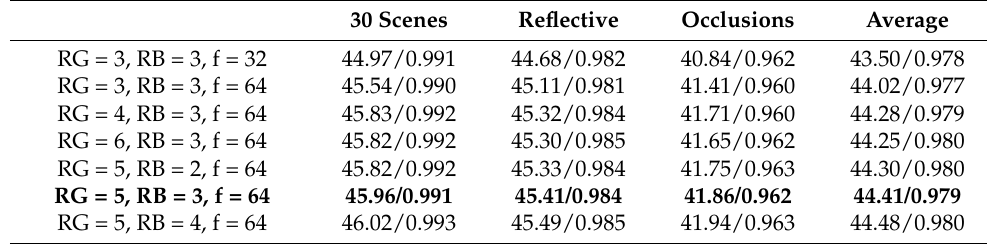
Table 2. Numerical comparison (PSNR/SSIM) of four different models with the same number of convolutional layers but with different residual connections. The results of the proposed model are in bold. RG RB 30 Scenes Reflective Occlusions Average X X 37.21/0.956 40.55/0.969 34.60/0.938 37.45/0.955 √ X 45.64/0.990 45.22/0.982 41.52/0.960 44.13/0.978 √ X 45.89/0.991 45.42/0.983 41.78/0.961 44.36/0.978 √ √ 45.96/0.991 45.41/0.984 41.86/0.962 44.41/0.979 Table 3. Numerical comparison (PSNR/SSIM) of seven different models with a varying number of Residual Groups and Residual Blocks to reconstruct 7 × 7 views out of 3 × 3 views on dataset 30 Scenes, Reflective, and Occlusions. The results of the proposed model are in bold. 30 Scenes Reflective Occlusions Average RG = 3, RB = 3, f = 32 44.97/0.991 44.68/0.982 40.84/0.962 43.50/0.978 RG = 3, RB = 3, f = 64 45.54/0.990 45.11/0.981 41.41/0.960 44.02/0.977 RG = 4, RB = 3, f = 64 45.83/0.992 45.32/0.984 41.71/0.960 44.28/0.979 RG = 6, RB = 3, f = 64 45.82/0.992 45.30/0.985 41.65/0.962 44.25/0.980 RG = 5, RB = 2, f = 64 45.82/0.992 45.33/0.984 41.75/0.963 44.30/0.980 RG = 5, RB = 3, f = 64 45.96/0.991 45.41/0.984 41.86/0.962 44.41/0.979 RG = 5, RB = 4, f = 64 46.02/0.993 45.49/0.985 41.94/0.963